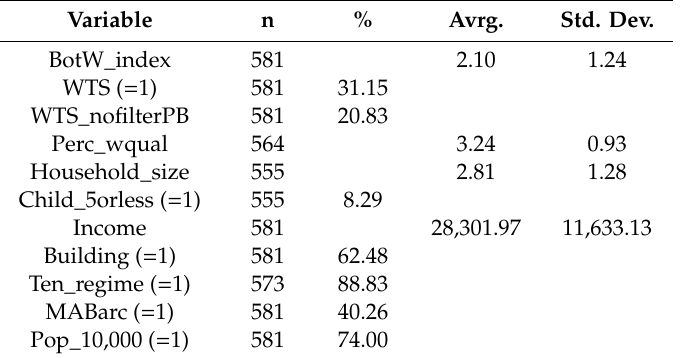
Table 3. Descriptive statistics of the dependent and independent variables of the models.